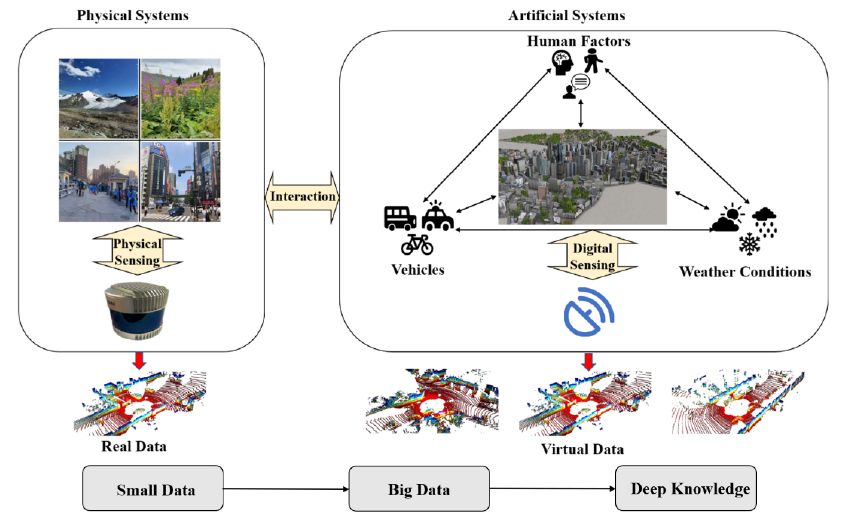
Figure 4. Descriptive Radars: the framework and